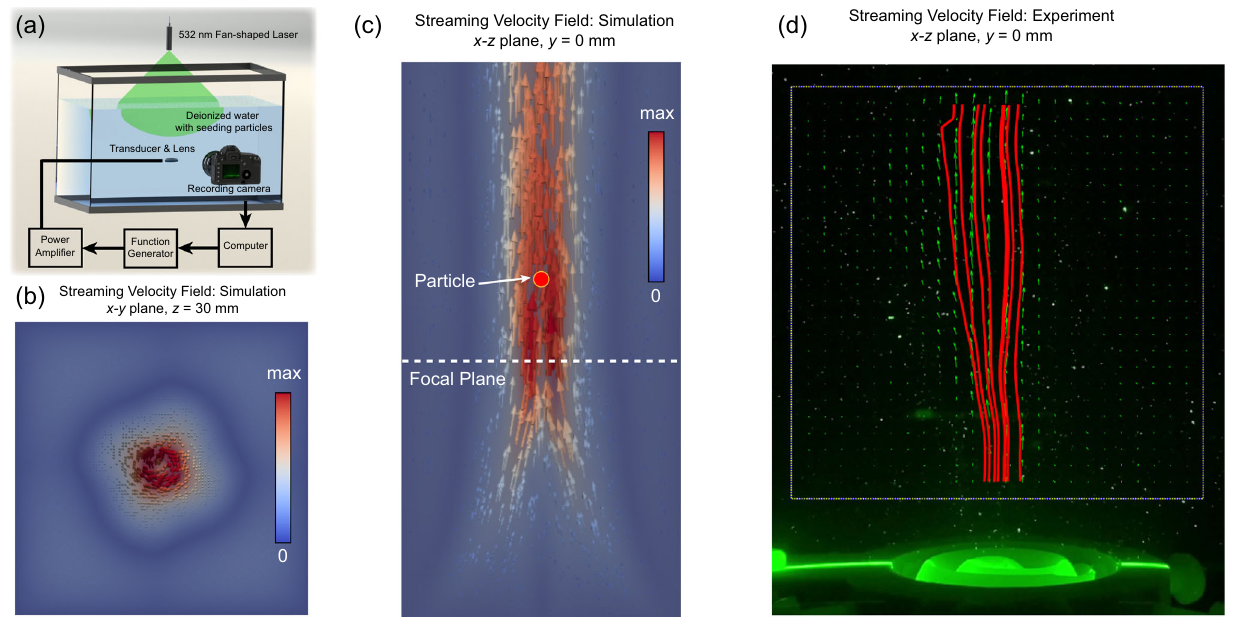
Fig. 3 Streaming fi eld measurement setup and results. a Illustration of the streaming fi eld measurement setup. b Simulation of streaming velocity fi eld within x – y plane at z = 30 mm. The streaming fl ow is focused in the central region, forming a streaming vortex. c Simulation of streaming velocity fi eld along x – z plane at y = 0 mm. The velocity increases towards the focal point, and gradually decreases after a certain height. The low velocity along the node line is the results of the streaming vortex. The red dot denotes the trapped particle. d Measured streaming velocity fi eld along x – z plane at y = 0 mm, in fair agreement with the simulation. The red lines denote the streamline, while the green arrows show the local streaming velocity.